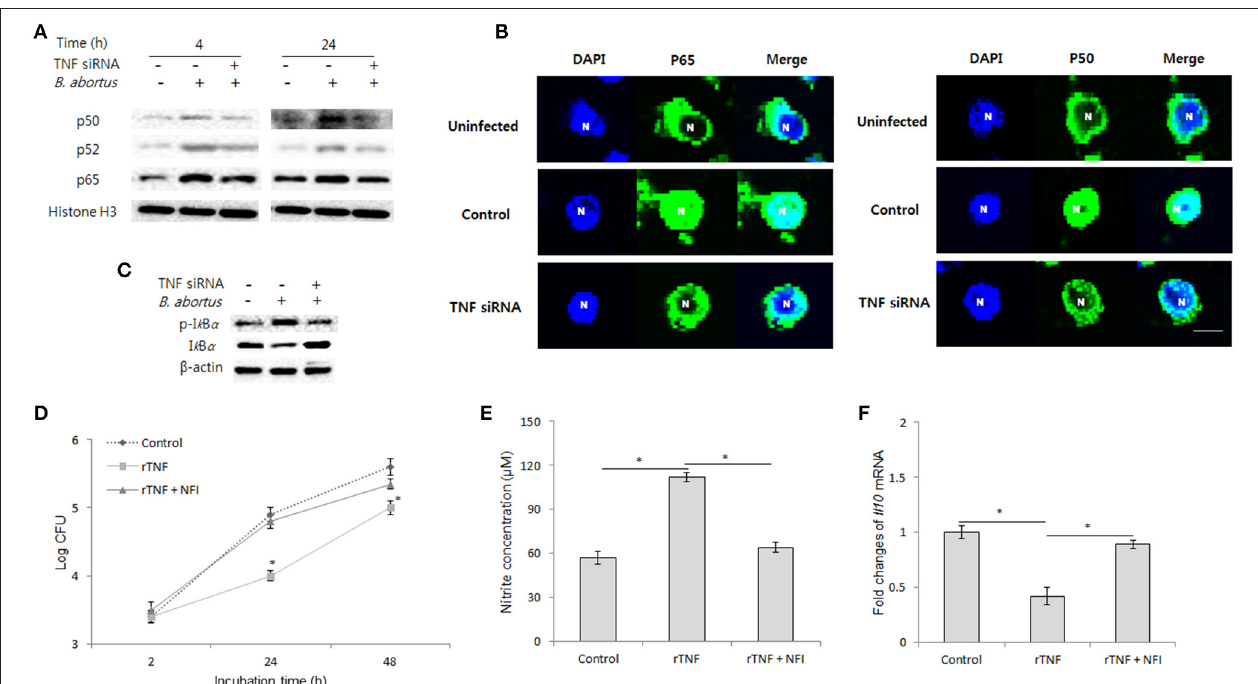
FIGURE 6 | NF- k B plays a major role in TNF/TNFR-1 signaling during B. abortus infection. Infected RAW 264.7 cells were treated with either recombinant TNF (rTNF) or TNF siRNA and subjected to isolation of nuclear protein fractions. The activation of NF- k B proteins was determined by Western blot assay (A) . Further observation of NF- k B translocation was performed by fluorescence microscopy (B) . The phosphorylation level of I k B α was checked by Western blot from total cellular protein extraction (C) . To examine the actual role of transcriptional factor NF- k B in TNF signaling, the cells were concomitantly treated with rTNF and NF- k B translocation inhibitor (NFI), and the intracellular growth of Brucella was evaluated (D) . The concentration of nitrite (E) in culture supernatant and transcriptional level of Il10 (F) was checked by Griess reaction and qRT-PCR at 24h pi, respectively. Data represent the mean ± SD of triplicate experiments. An asterisk indicates a significant difference ( P <